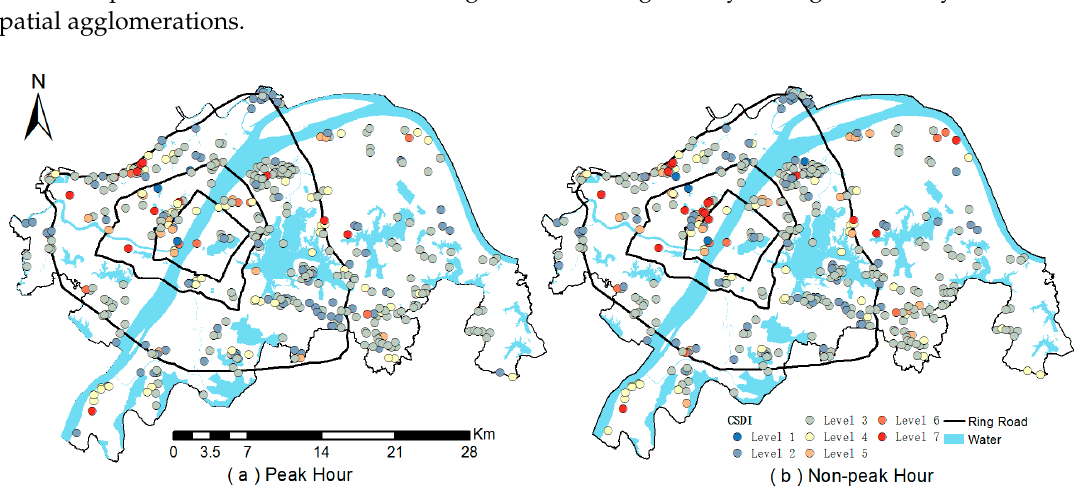
Figure 14. Comprehensive supply–demand index (CSDI) distribution. ( a ) and ( b ) CSDI during